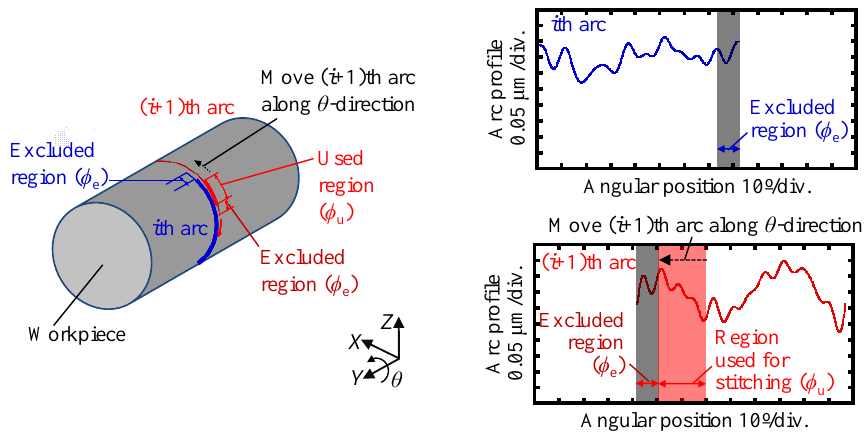
Figure 8. Exclusion of the edge data in the arc-profiles for the circumferential stitching.